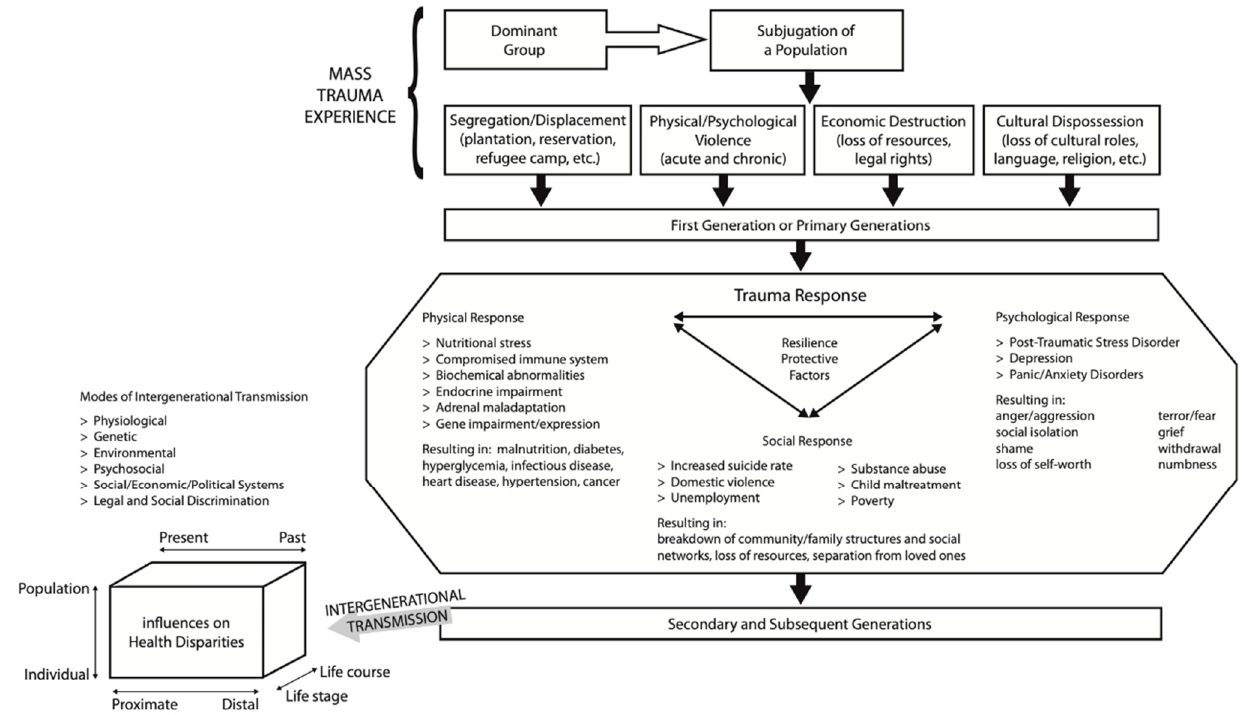
Figure 1. Conceptual model of historical trauma. Source: Sotero (2006, p. 99).